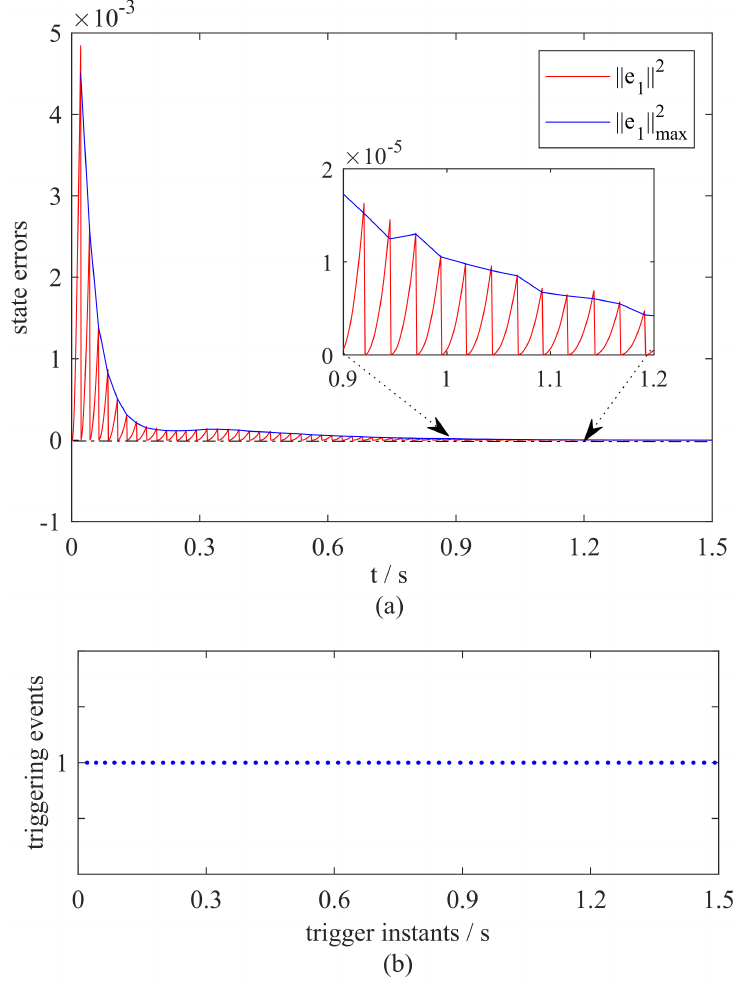
Figure 6. ( a ) Performance of the distributed event-triggered control law for agent 1. ( b ) The event- triggered time instants of agent